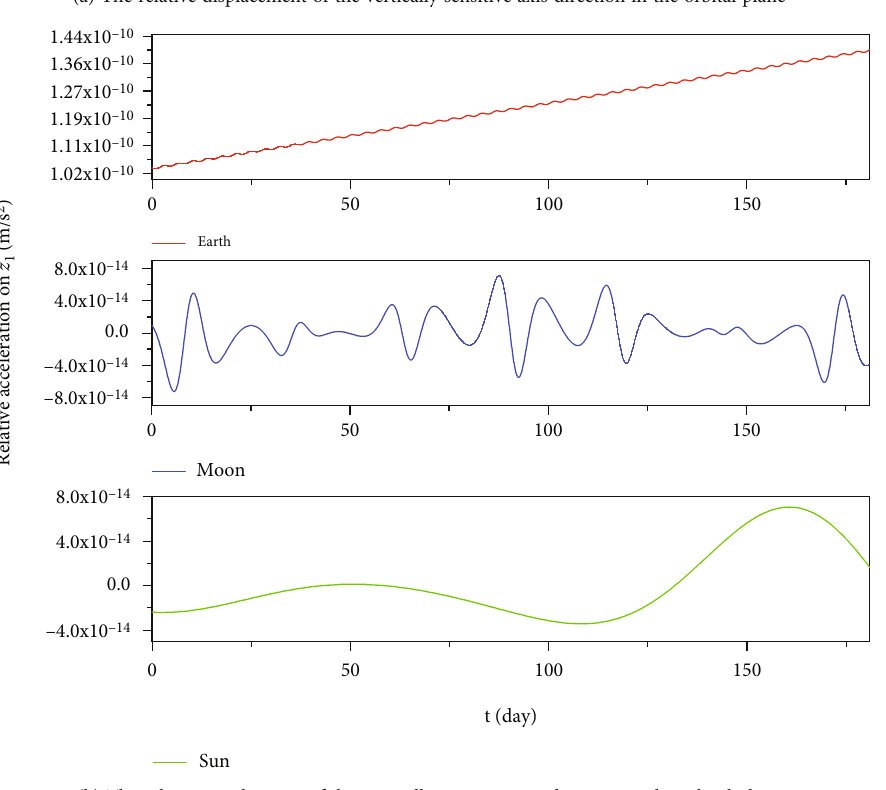
Figure 5: The e ff ect of the Earth-moon-sun system on the relative motion in the vertically sensitive axis